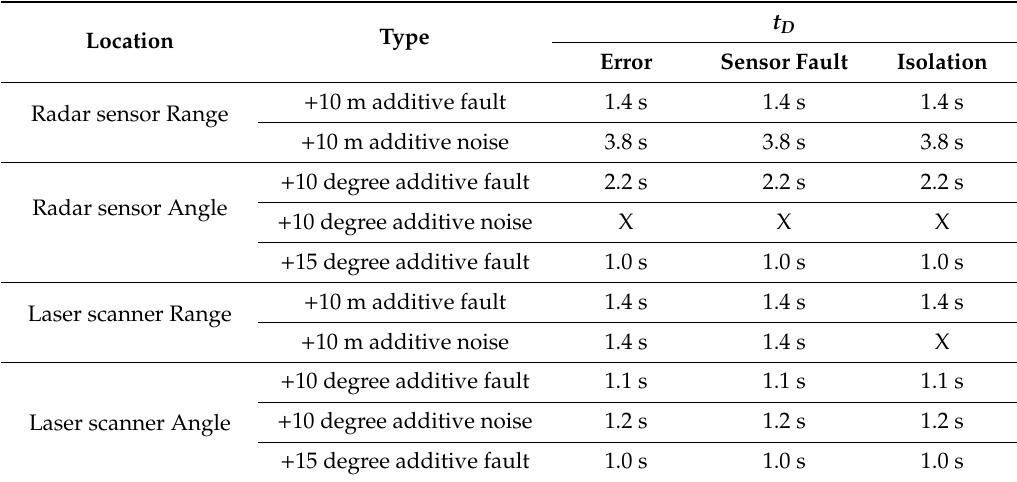
Table 1. Results of fault injection